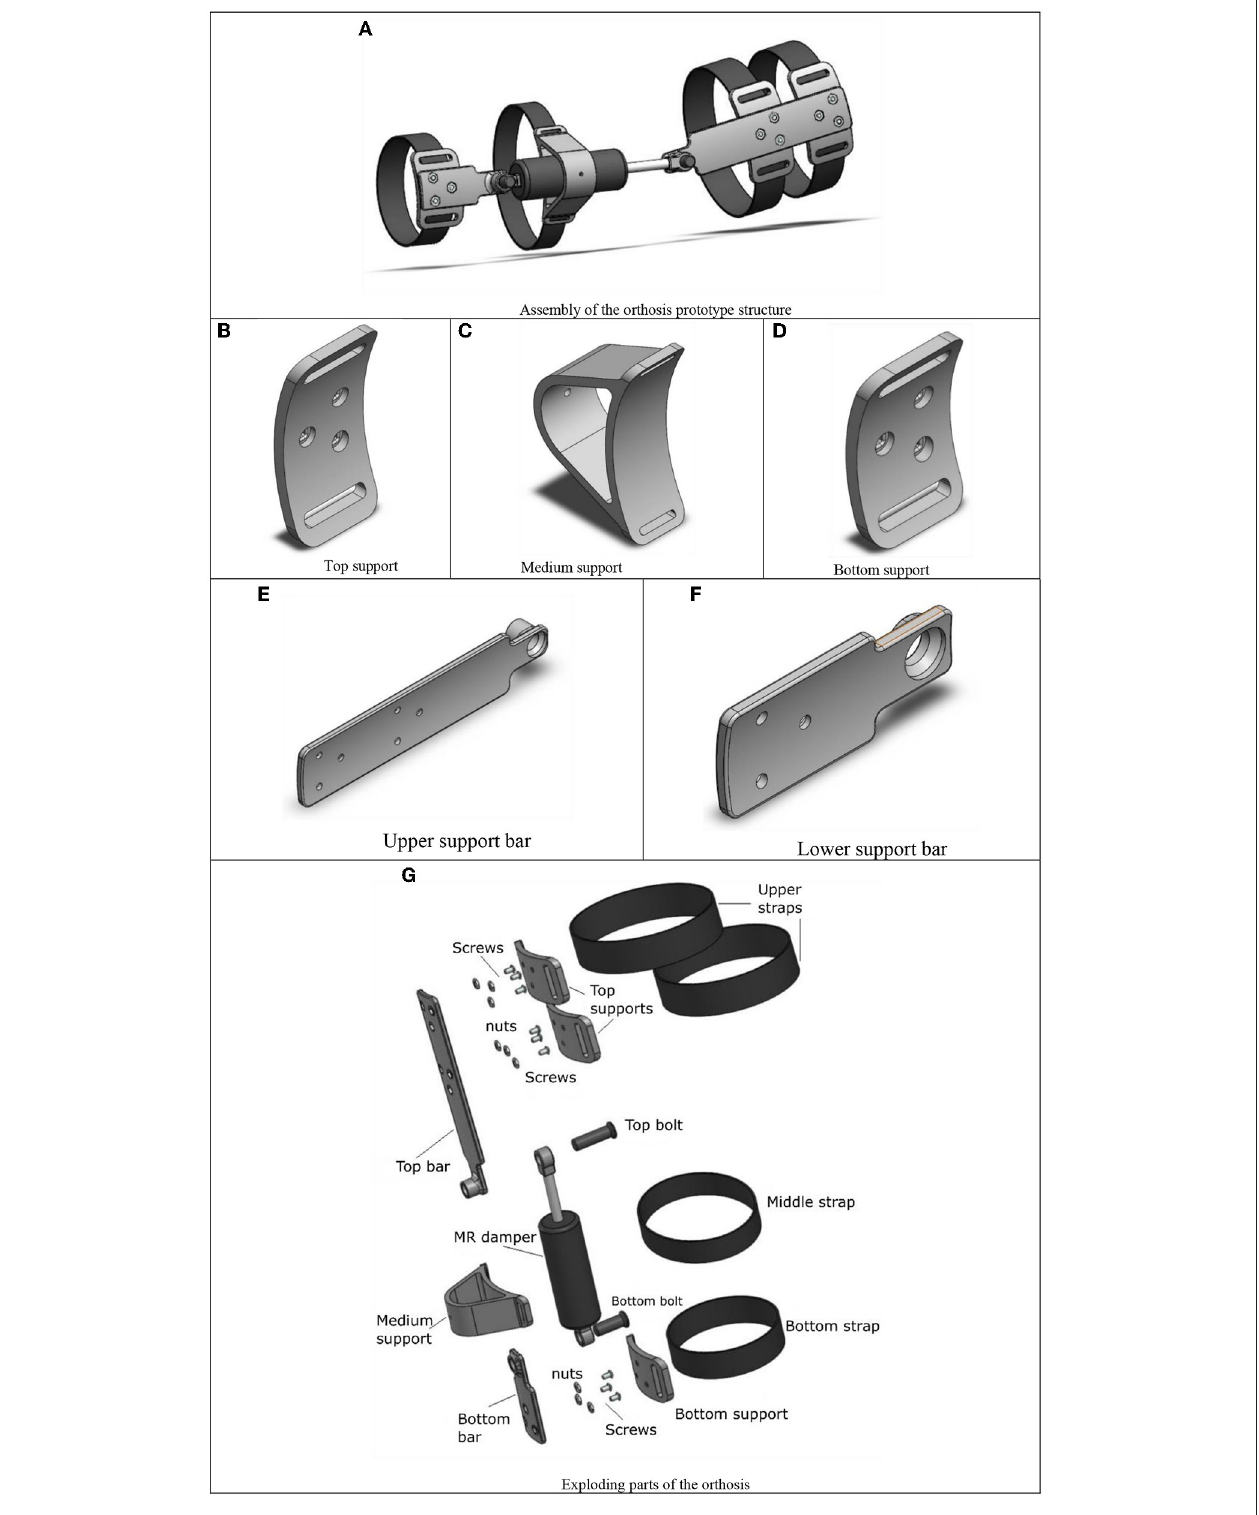
FIGURE 12 | CAD model of the semiactive orthosis. (A) Assembly of the orthosis prototype structure. (B) Top support. (C) Medium support. (D) Bottom support. (E) Upper support bar. (F) Lower support bar. (G) Exploding parts of the orthosis.